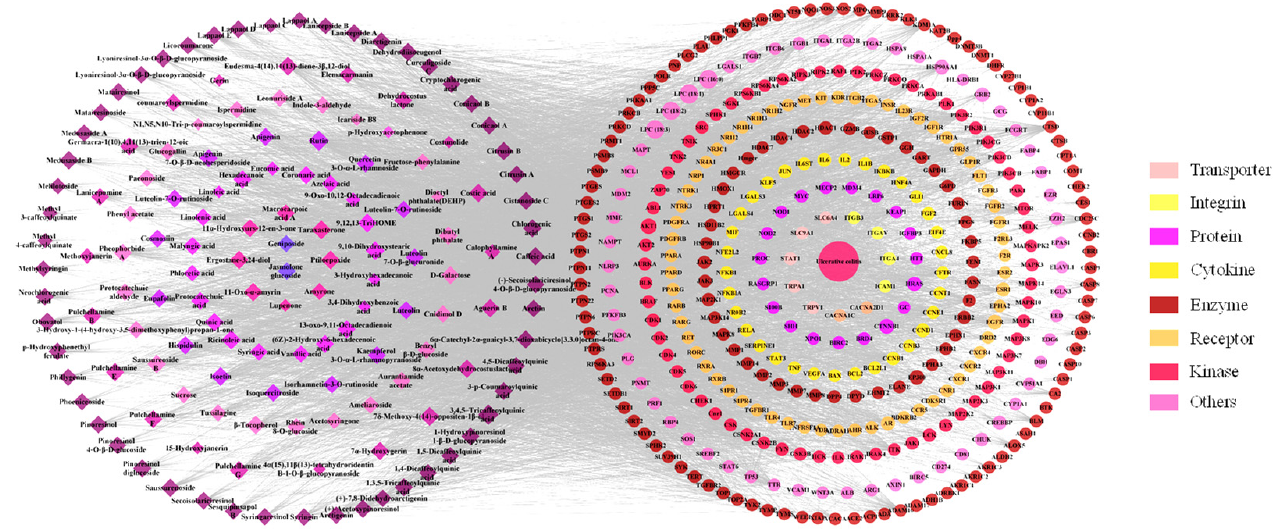
Figure 10. The network of SP-core targets and PPI network.